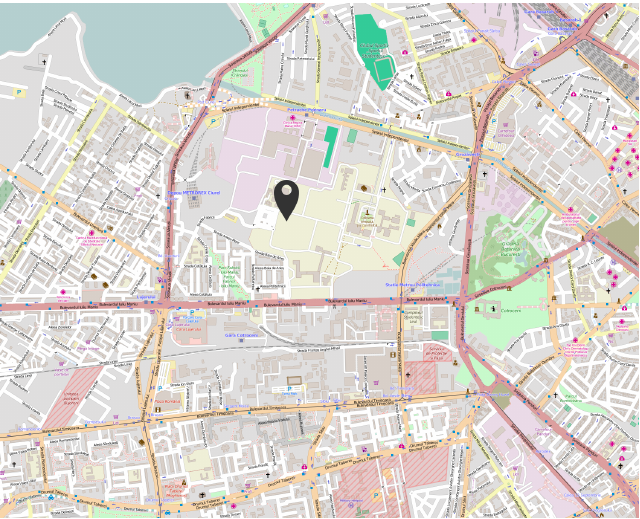
Figure 6. University Politehnica of Bucharest campus, location of the first urban area sensing